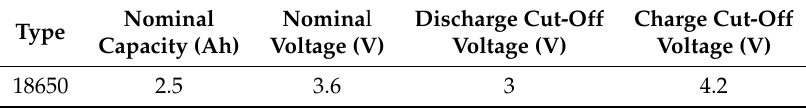
Figure 2. Battery cell test bench. Table 1. Specifications of the ternary lithium-ion battery